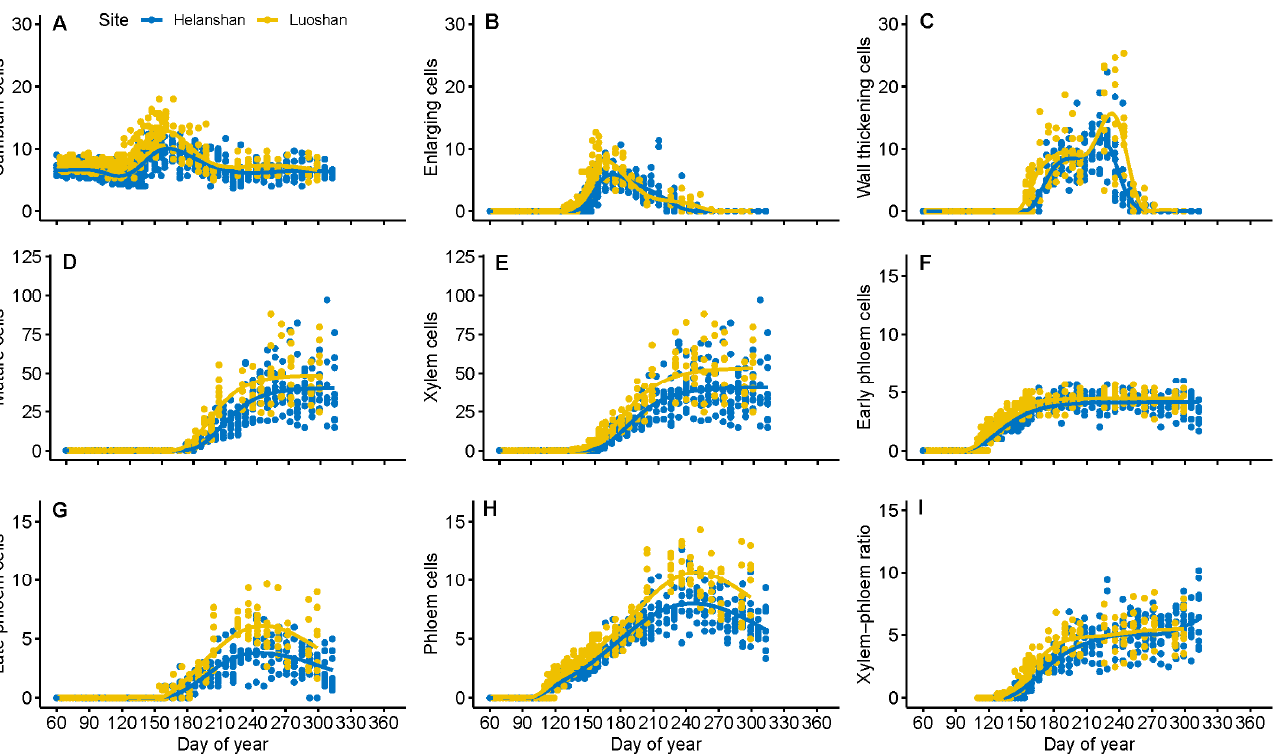
Figure 3. Dynamics and fitting curves of cambium activity ( A ) and xylem and phloem formation ( B – I ) of Picea crassifolia in Helanshan and Luoshan in 2019. Values are presented as the mean values (computed by averaging the measured data along three radial files per sample) of sampled trees at each sampling date. Smoothed lines in ( A – C , G – I ) were drawn using Generalized additive models (GAMs) and Gompertz functions, respectively.